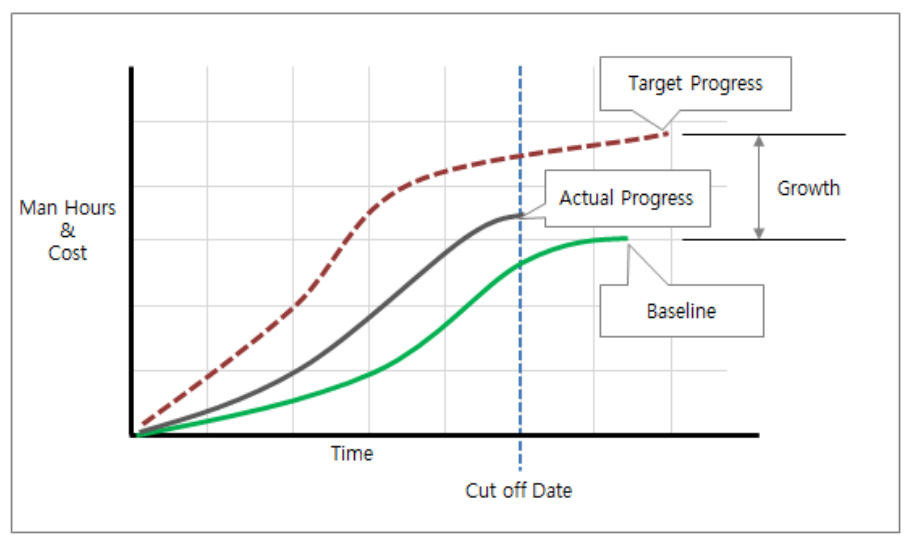
Figure 5. Calculation of Project Progression using S ‐ curve.